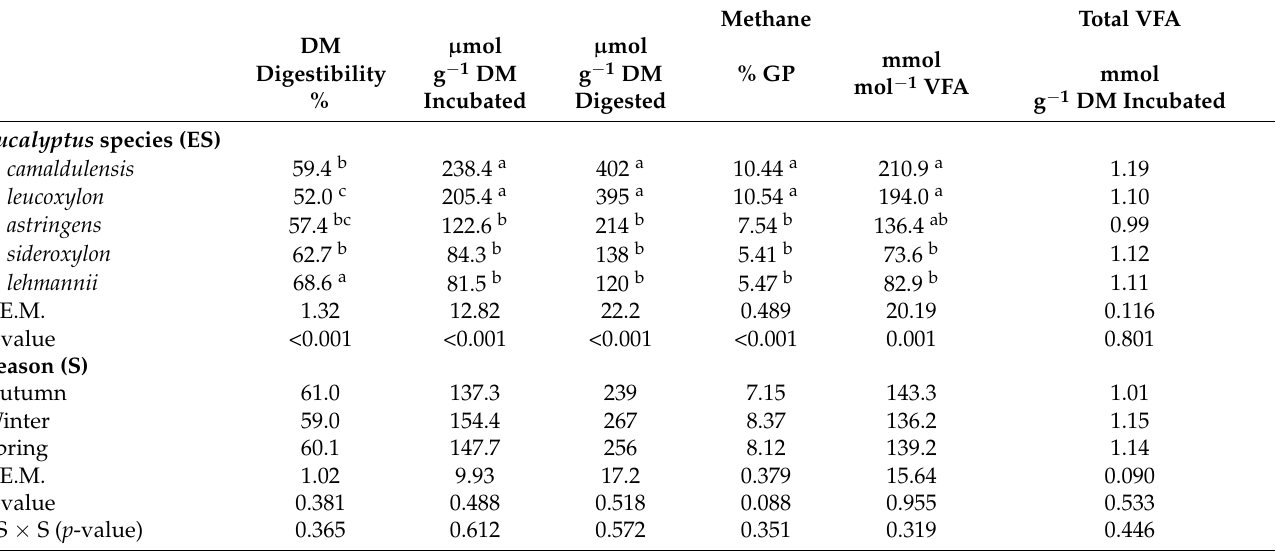
Table 3. Methane and total volatile fatty acid (VFA) production when the foliage of eucalyptus species harvested in different seasons was incubated in vitro in buffered rumen fluid for 24